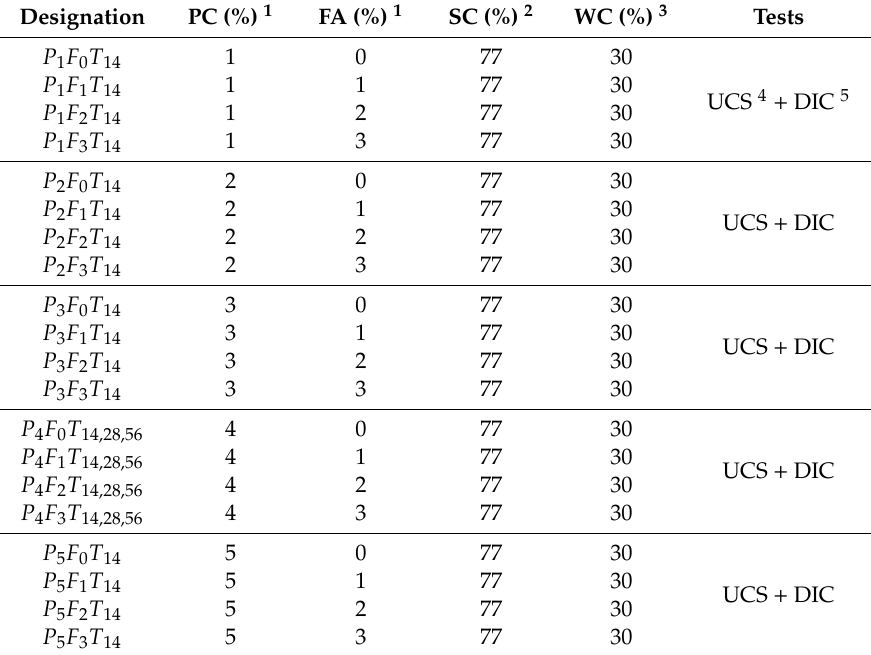
Table 4. Mix designs and their